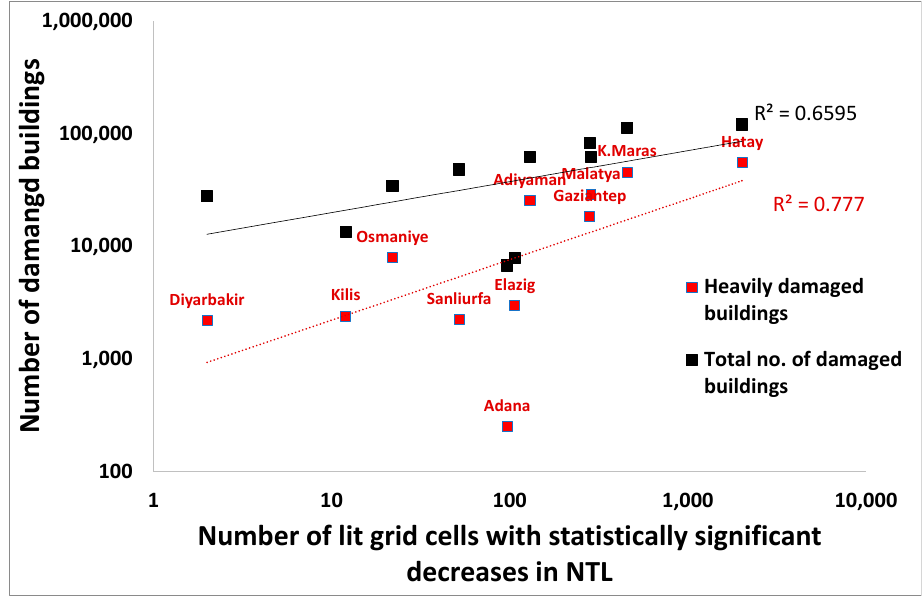
Figure 9. The correspondence between VIIRS lit grid cells that experienced statistically significant decreases in NTL before and after the 7.8 magnitude earthquake and damaged buildings at the province level in Turkey, as of 27 February 2023 (source: [26]).